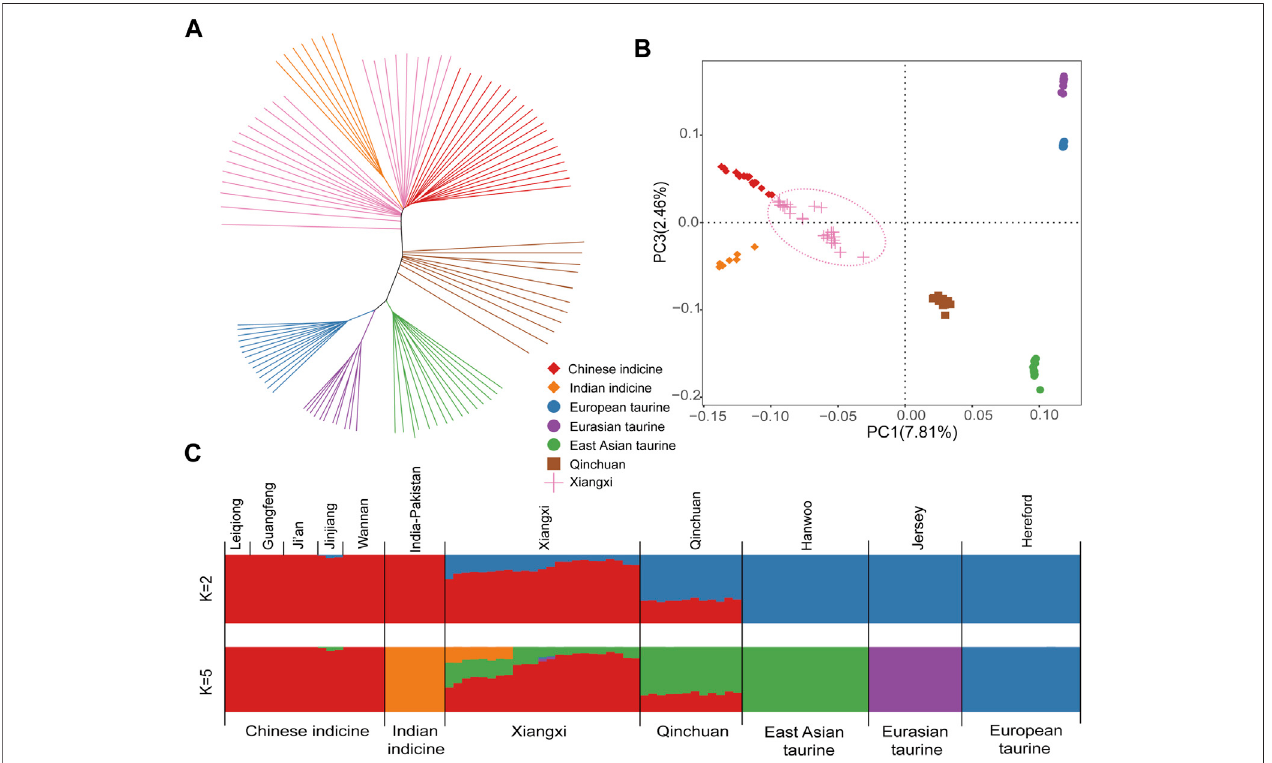
FIGURE 1 | Population genetic analysis of Xiangxi cattle. (A) The Neighbor-joining tree of relationships among 7 populations (B) The principal component analysis of cattle with PC1 against PC3 (C) genetic structure of cattle using ADMIXTURE with K = 2 and K = 5.